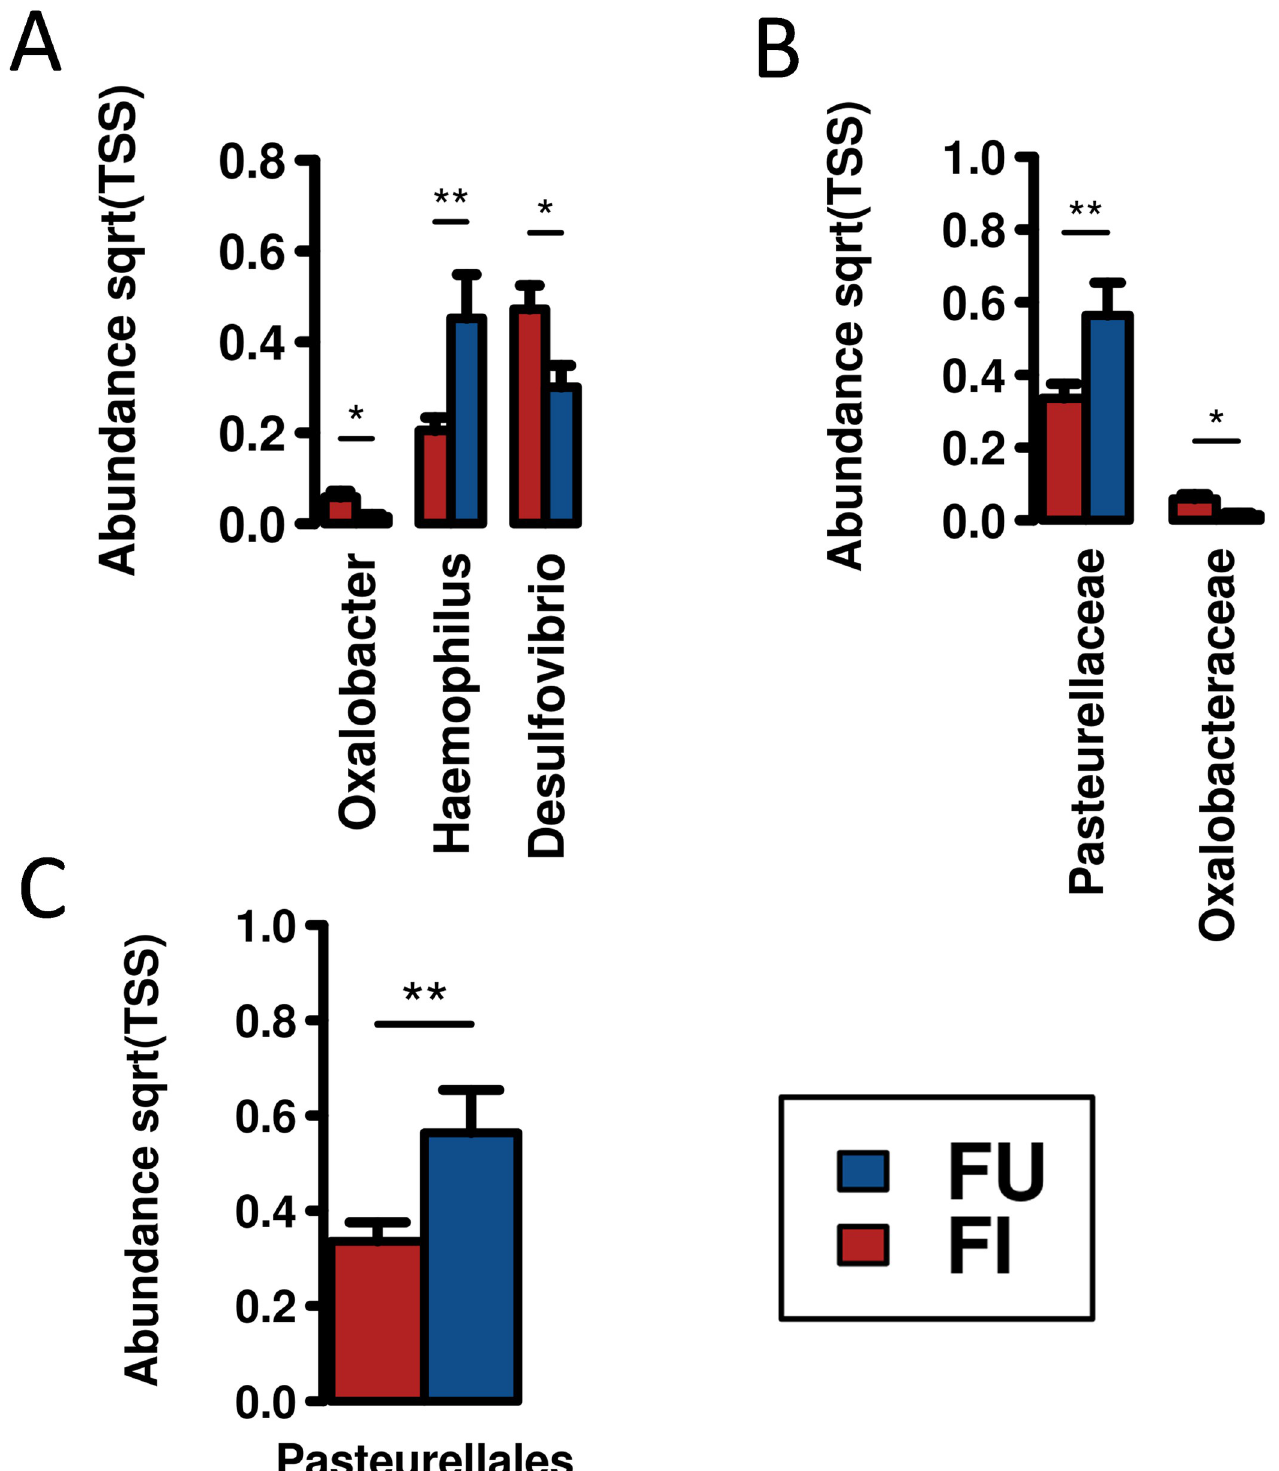
Fig 4. Univariate analysis shows altered taxa in the faecal samples of individuals with helminth infection (red bars) compared to uninfected (blue bars) individuals. Statistically significant A. genera, B. families and C. order are presented. � = p-value � 0.05; �� = p-value � 0.01. Complete lists of ANOVA is presented in S3